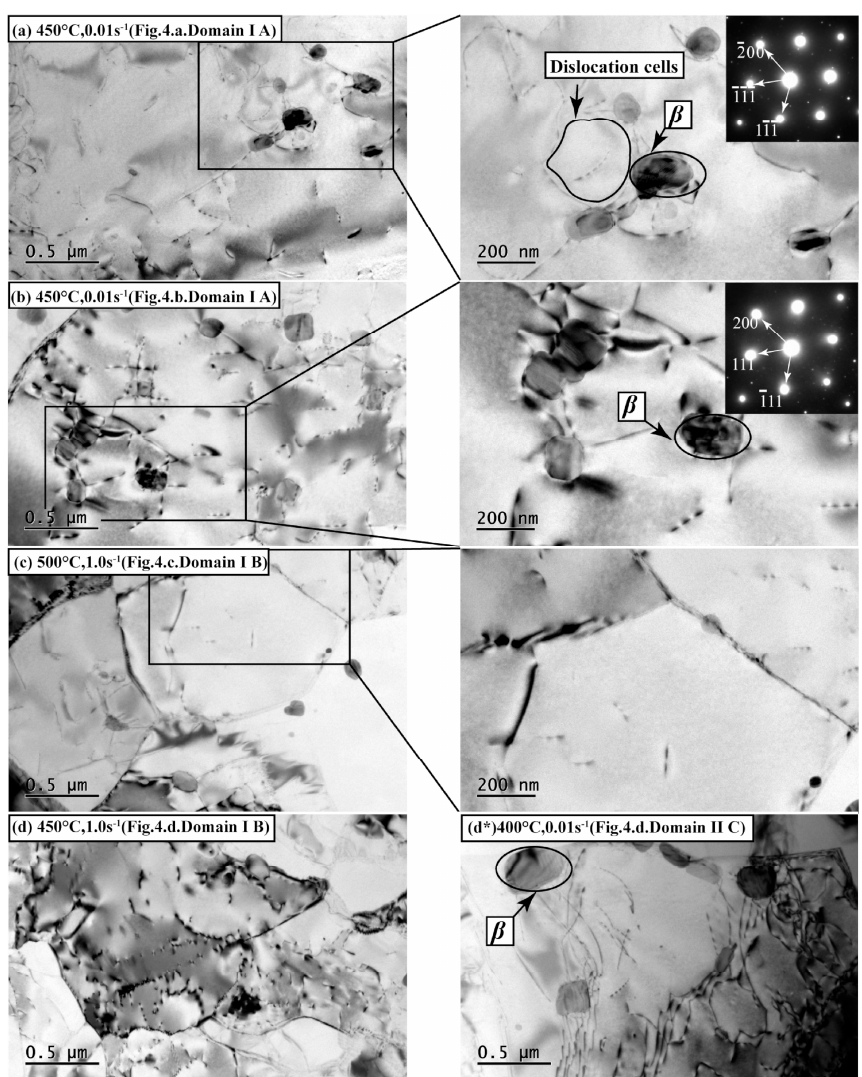
Figure 9. The TEM images after deformation at ( a ) 450 °C, 0.01 s − 1 /0.69 strain; ( b ) 450 °C, 0.01 s − 1 /0.92 strain; ( c ) 500 °C, 1.0 s − 1 /1.20 strain; ( d ) 450 °C, 1.0 s − 1 /1.38 strain and and ( d* ) 400 °C, 0.01 s − 1 /1.38 strain. ( β is the second phase of the alloy).